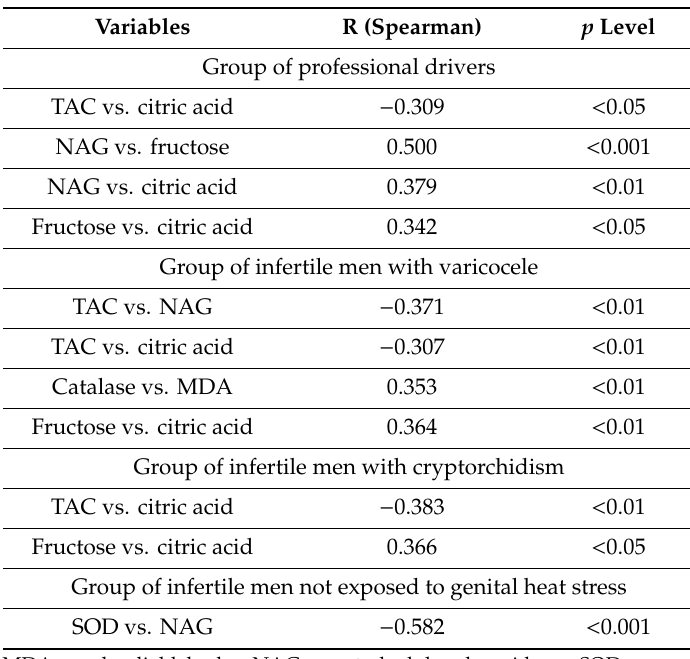
SOD vs. NAG − 0.582 <